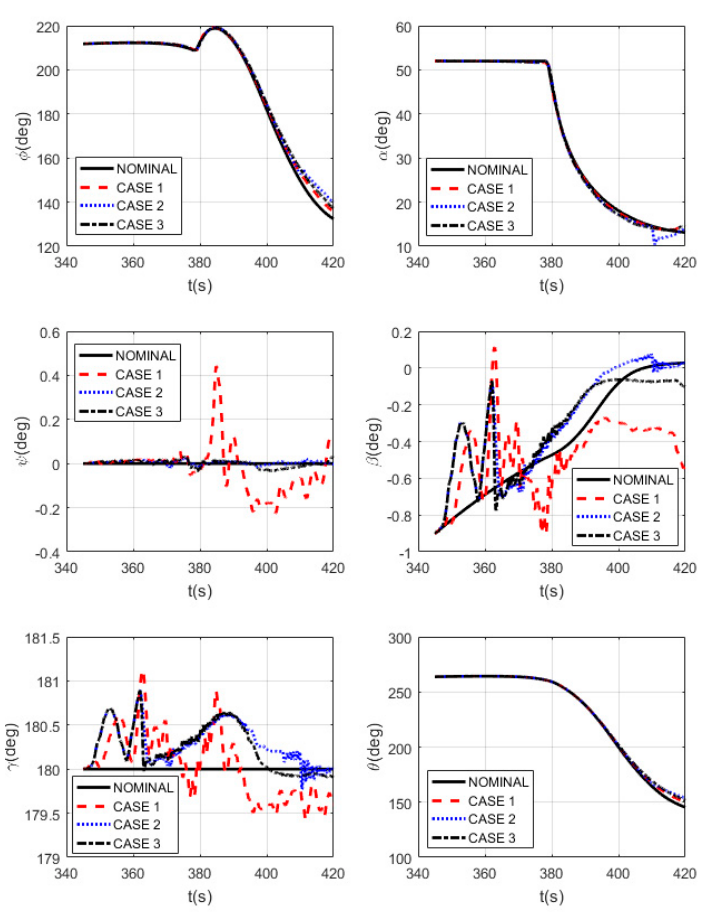
Figure 6. The attitude angles of the RLV.